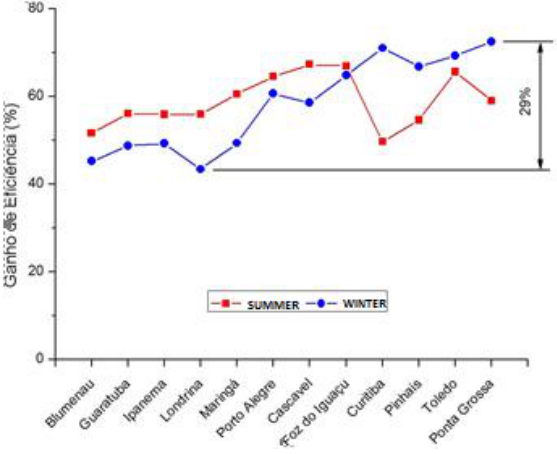
Figure 7: Energy efficiency gain in summer and winter in all stations with the replacement of the conventional system by geothermal system.